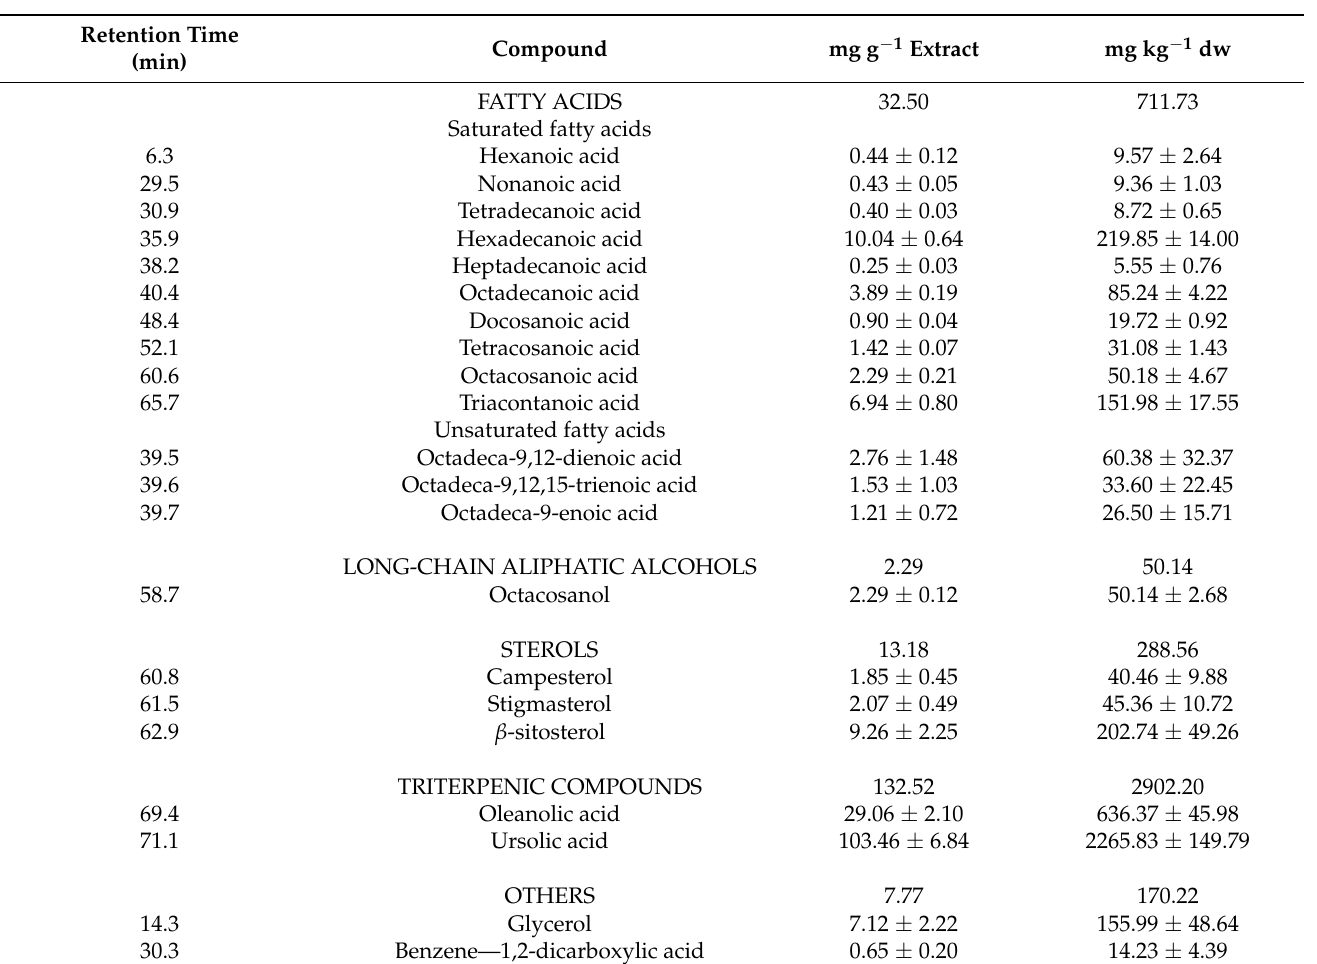
Table 2. Lipophilic compounds determined in elderberry stalk dichloromethane extract expressed in mg g − 1 of extract and mg kg − 1